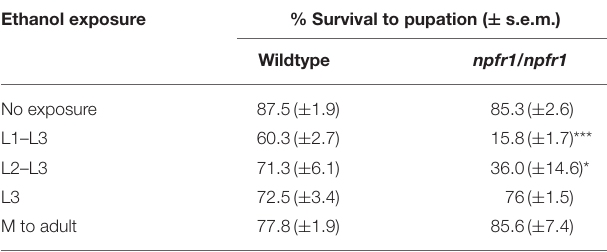
TABLE 1 | Critical periods for ethanol-induced toxicity in npfr1 mutant flies. Ethanol exposure % Survival to pupation ( ±